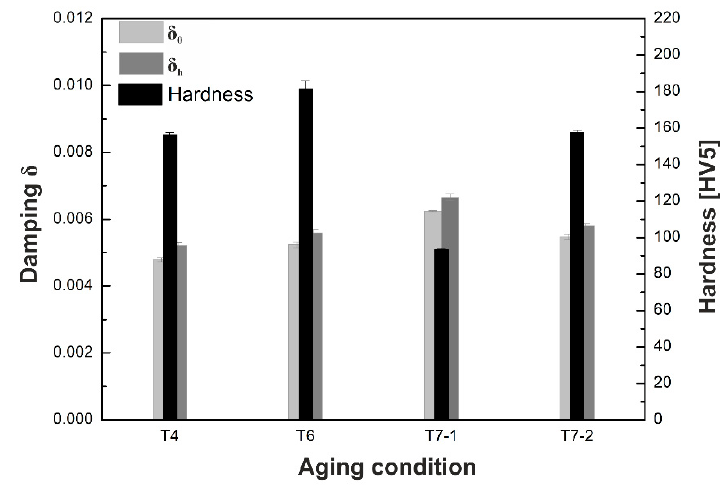
Figure 3. Damping and hardness in dependence of heat treatment condition.